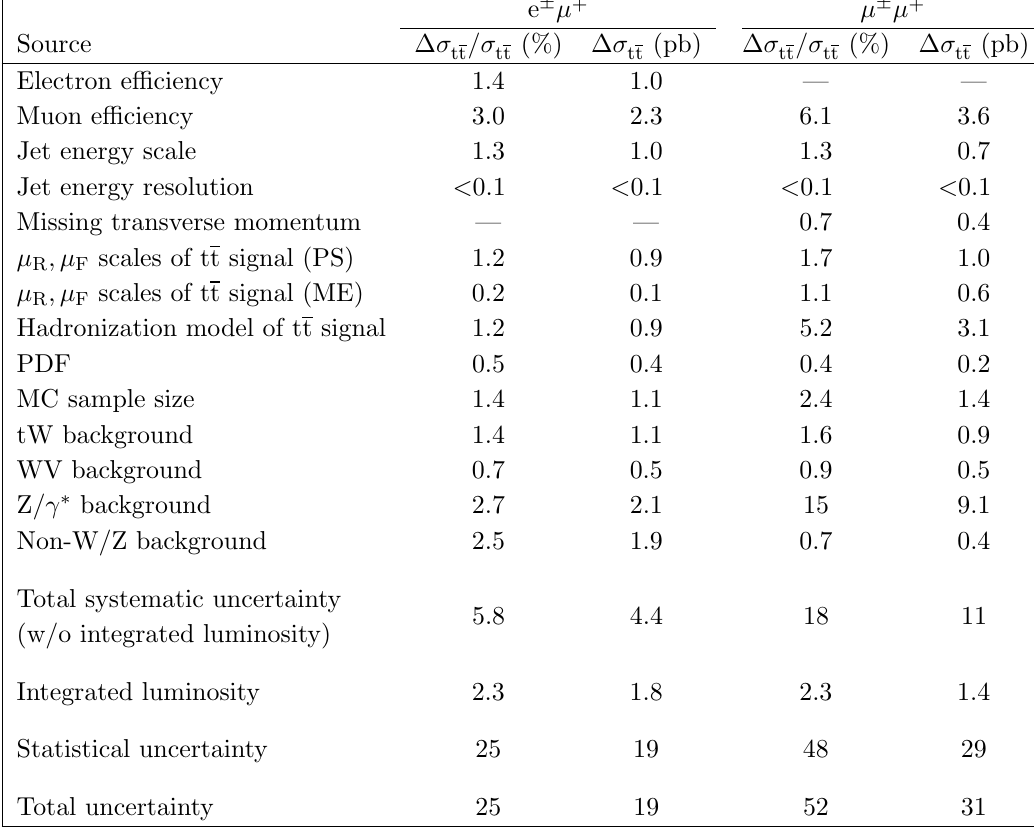
Table 4 . Summary of the individual contributions to the systematic uncertainty in the (cid:27) surements for the dilepton channels. The relative uncertainties (cid:1) (cid:27) uncertainties in (cid:27) , (cid:1) (cid:27) (in pb), are presented. The statistical and total uncertainties are also tt tt given, where the latter are the quadrature sum of the statistical and systematic